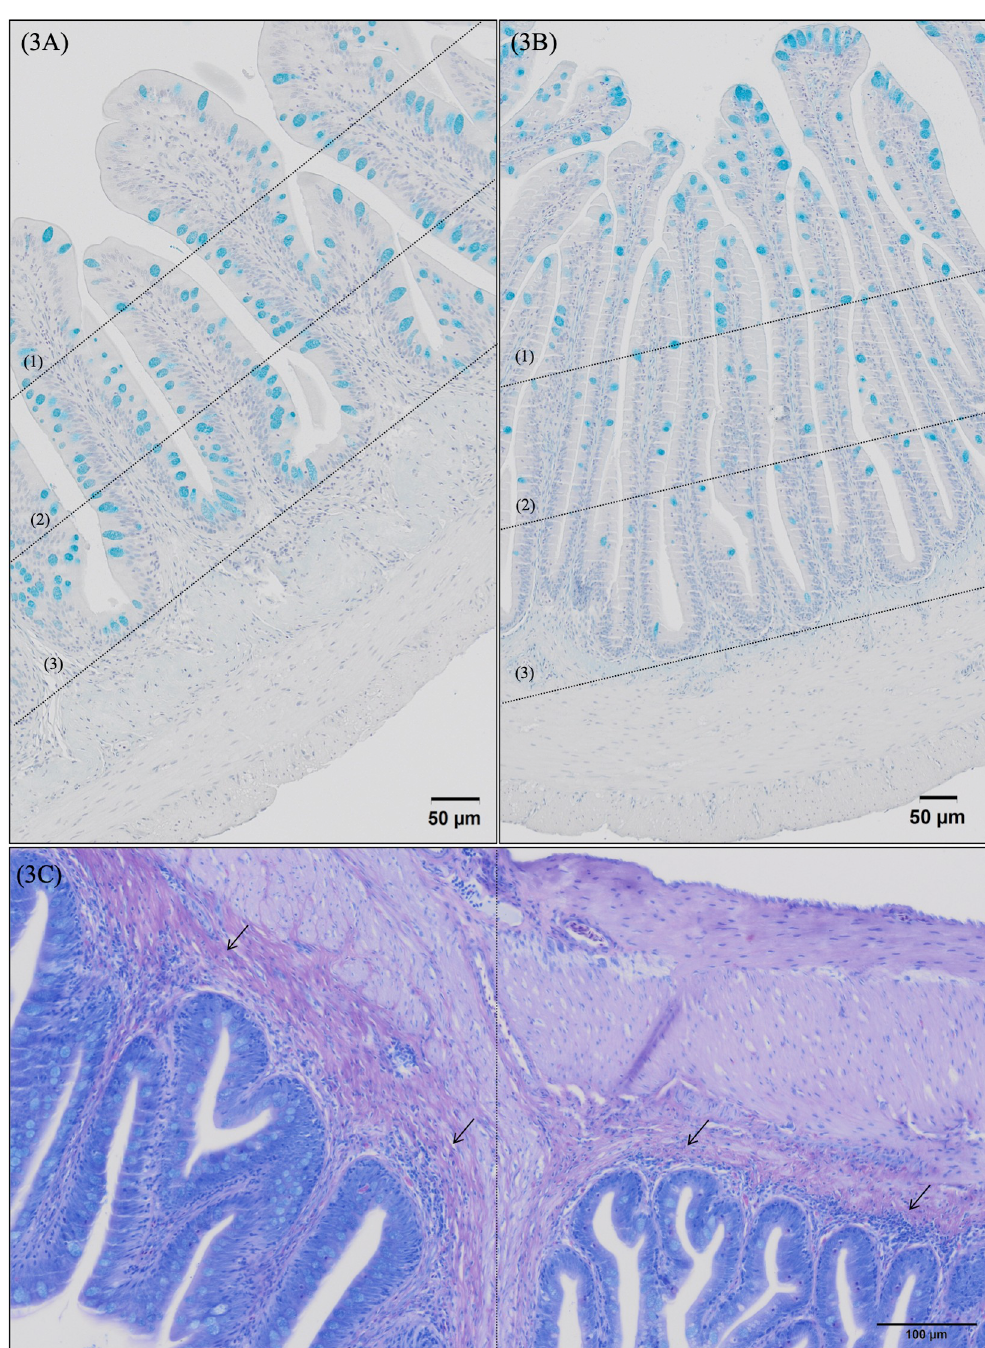
Fig 3. Detailed micrograph of posterior gut (3A) and rectum (3B) goblet cells distribution along the folds stained with Alcian Blue (pH = 2.5). Observe a higher density of goblet cells on posterior gut mid (2) and basal (3) fold regions compared to apical (1) fold region, whereas rectum presents greater goblet cell density on apical (1) and mid (2) regions in comparison to basal (3) zone. Scale bar 50 μ m. (3C) Detailed micrograph of posterior gut (preileorectal valve; right) and rectum (postileorectal valve; left) stained with May-Gu¨nwald Giemsa; observe the wider submucosa ( ! ) in posterior gut than in rectum segments. Scale bar 100 μ m.